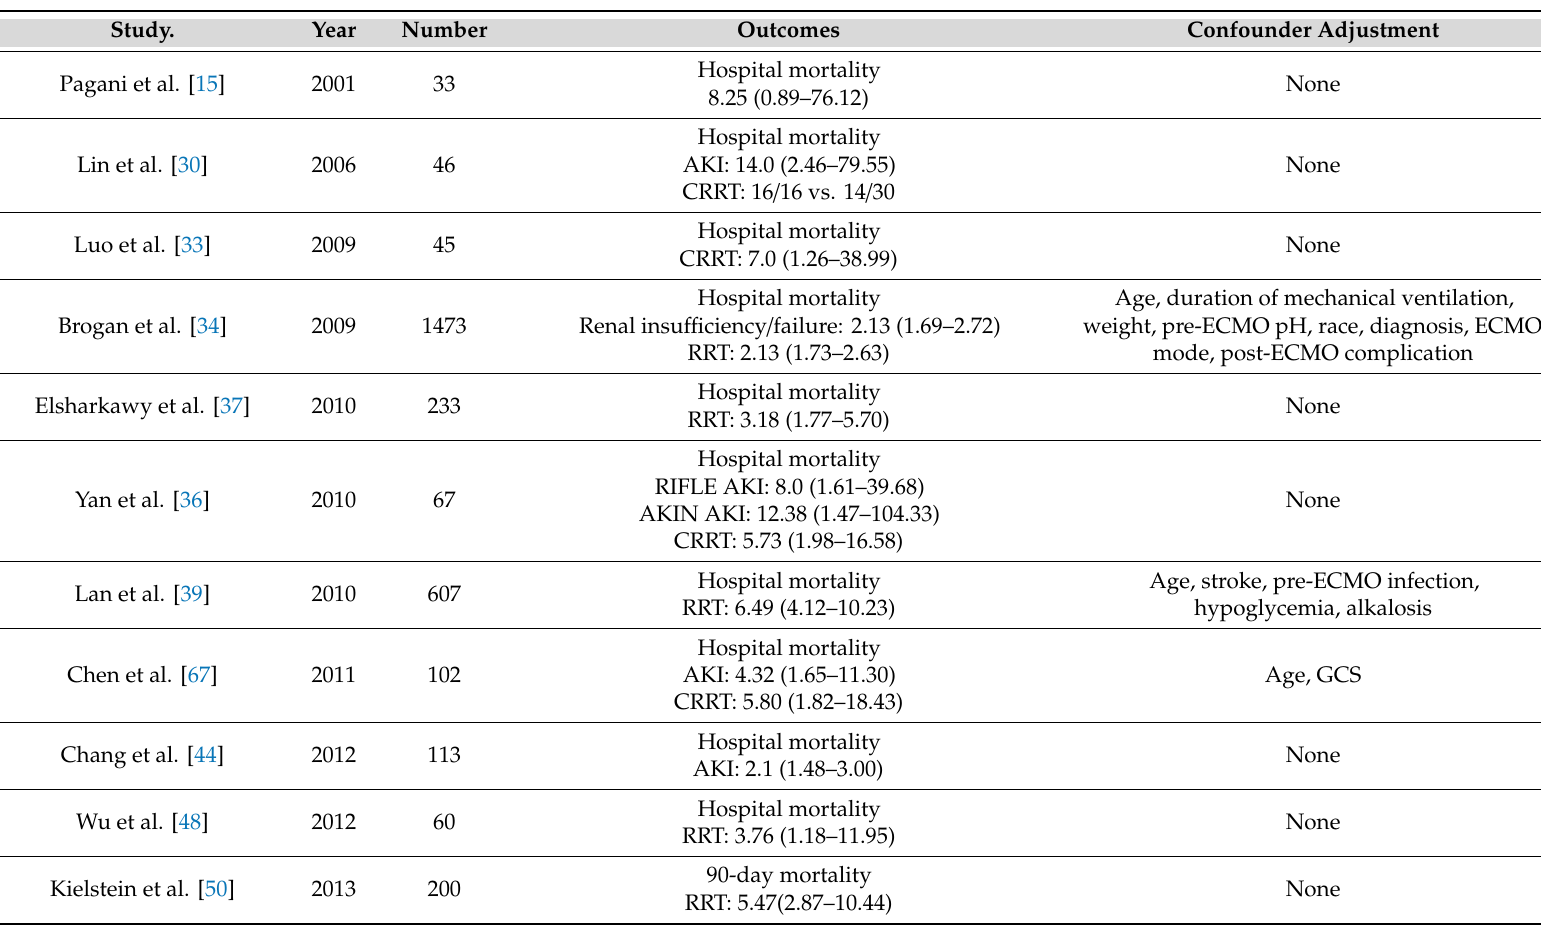
Table 2. Characteristics of studies included in this meta-analysis of AKI associated mortality risk among patients requiring ECMO. Study.